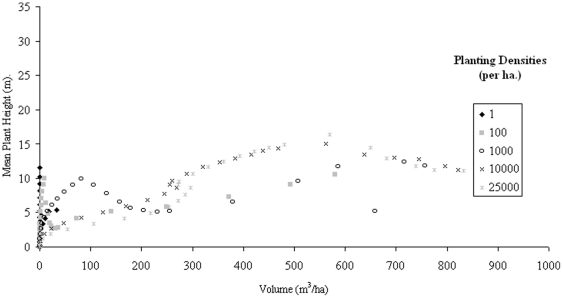

Abies Alba Hmean against stand volume over a period of 100 years.